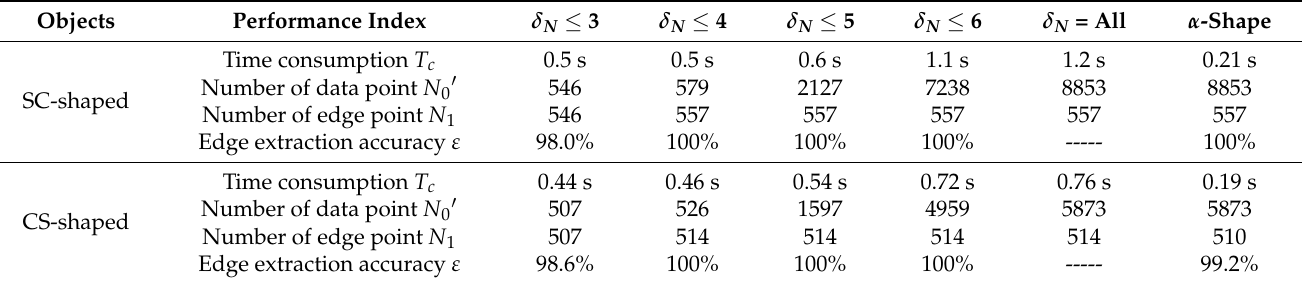
Table 1. Comparison analyses on the CDTM-based and α -shape boundary extraction results of SC-shaped and CS-shaped point clouds with different δ N . ( α sc = 0.6 and α cs = 0.55).